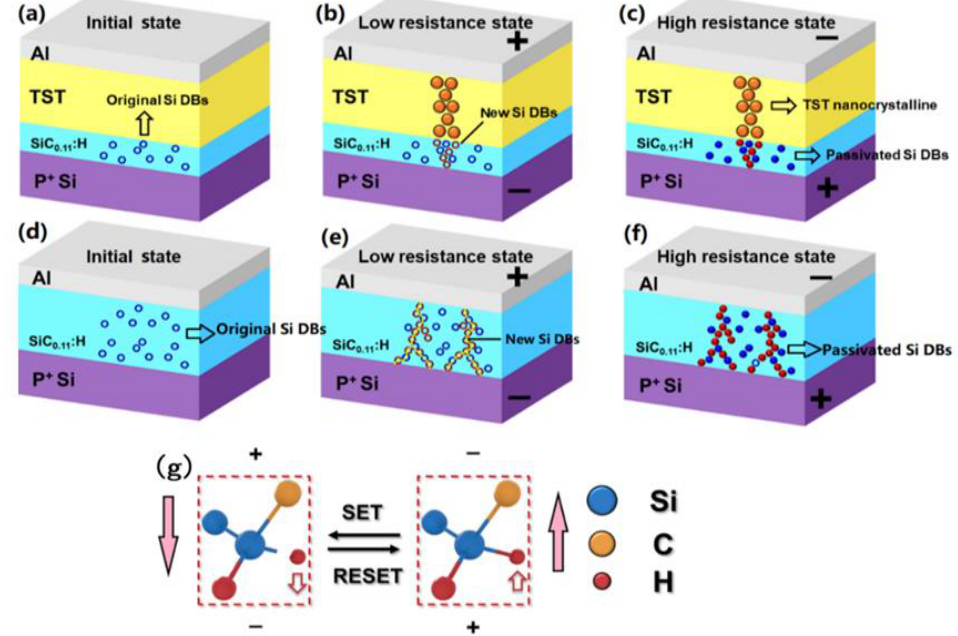
Figure 4. The resistive switching model of the Al/TST/a-SiC 0.11 :H/P + -Si device: ( a ) In the initial state, the Si dangling bonds distribute in the a-SiC 0.11 :H layer, which are represented by the blue circle; ( b ) In the LRS, TST nanocrystalline was produced under the DC positive voltage. The localized electric field of the TST nanocrystalline induced more Si DBs to aggregate under the TST nanocrystalline, forming an Si DB-conductive nanopathway; ( c ) In the HRS, H + moved back to accurately passivate the original Si dangling bonds under negative voltage, resulting in the rupture of the conductive nanopathway; ( d ) The resistive switching model of the Al/a-SiC 0.11 :H/P + -Si device. In the initial state, the Si dangling bonds were distributed in the a-SiC 0.11 :H layer, and are represented by the blue circles; ( e ) In the LRS, new Si DBs were formed from broken Si-H bond under a positive bias, forming a conductive nanopathway; ( f ) In the HRS, H + moved back to passivate some Si dangling bonds under a negative voltage, resulting in the rupture of the conductive nanopathway; ( g ) The breakage of the Si-H bonds and the passivation of the Si dangling bonds by H + under the electric field direction of forward and reverse direction made the pathway be broken up and